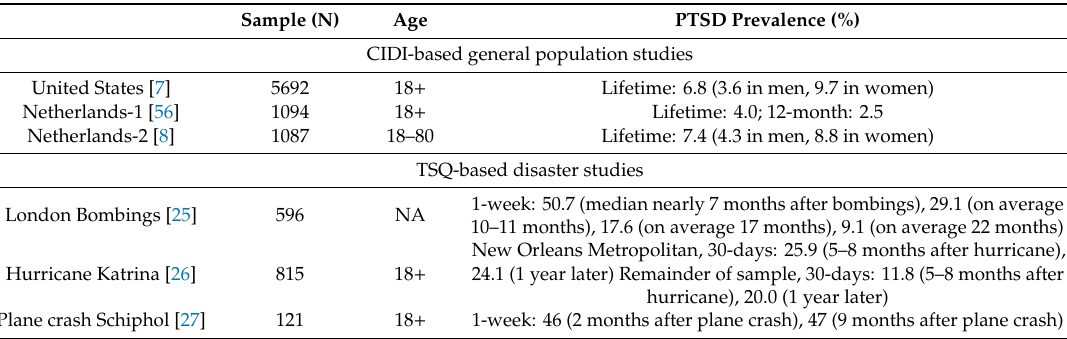
Table 4. Several Composite International Diagnostic Interview (CIDI)-based general population studies and TSQ-based disaster studies: PTSD